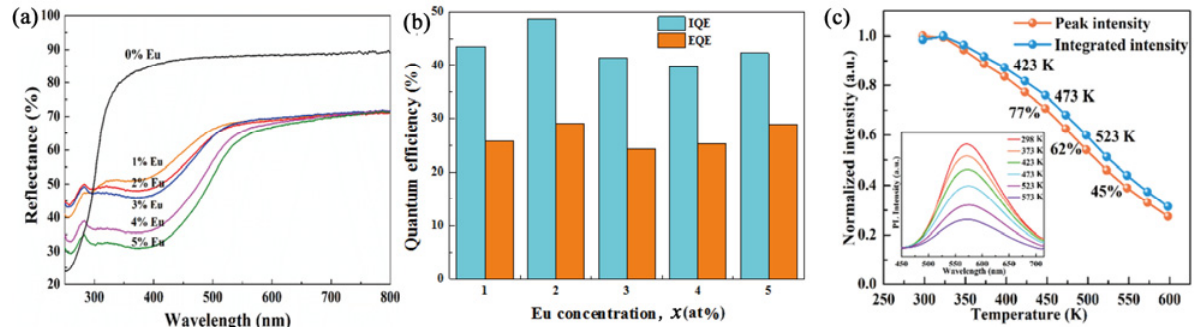
Fig. 6 (a) Diffuse reflectance spectra and (b) IQEs/EQEs of Sr 3 − 3 x Si 8 O 4 N 10 :3 x Eu 2+ phosphor powders under 450 nm excitation. (c) Temperature-dependent peak and integrated intensities of Sr 2.97 Si 8 O 4 N 10 :0.03Eu 2+ under 365 nm excitation. The inset in (c) is the emission spectra measured at different